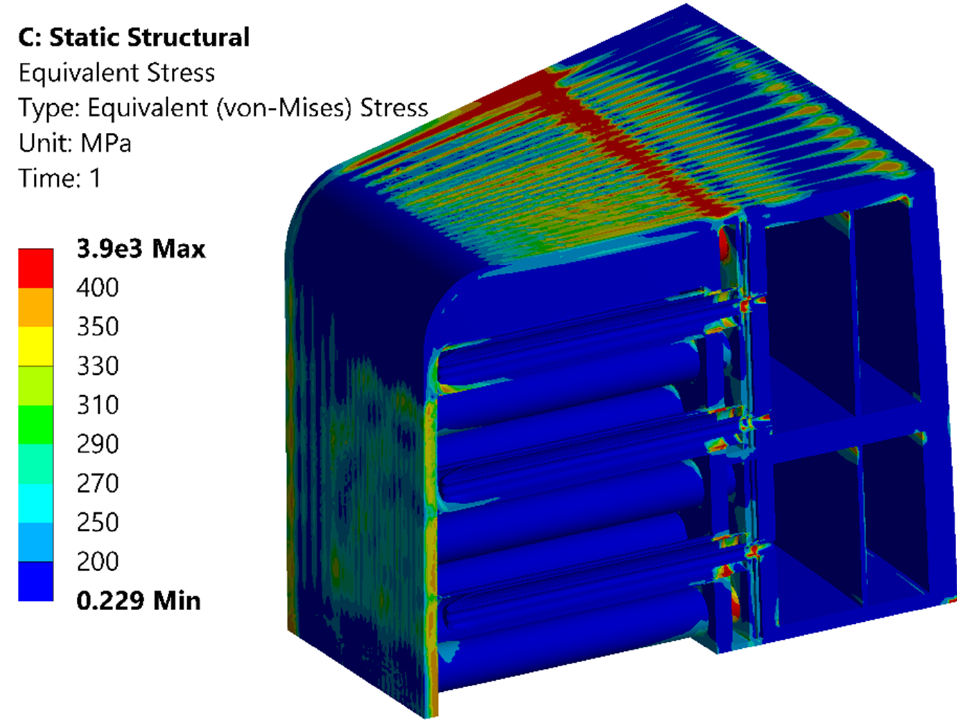
Figure 8. Von Mises stress results contour on BB cap region—elastic analysis.